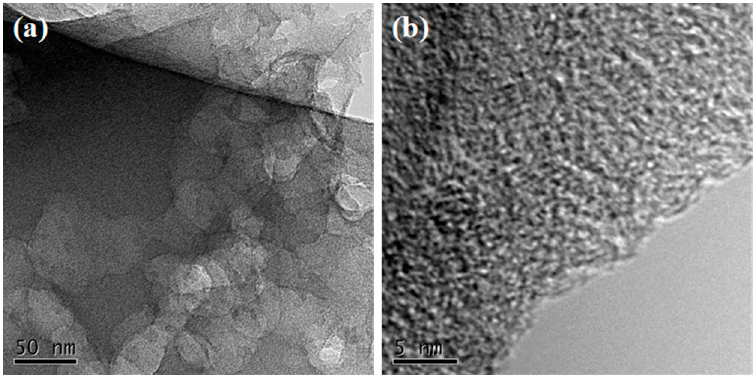
Figure 3. Transmission electron microscopy (TEM) image ( a ) and high-resolution TEM (HRTEM) image ( b ) of a-CSH-700.